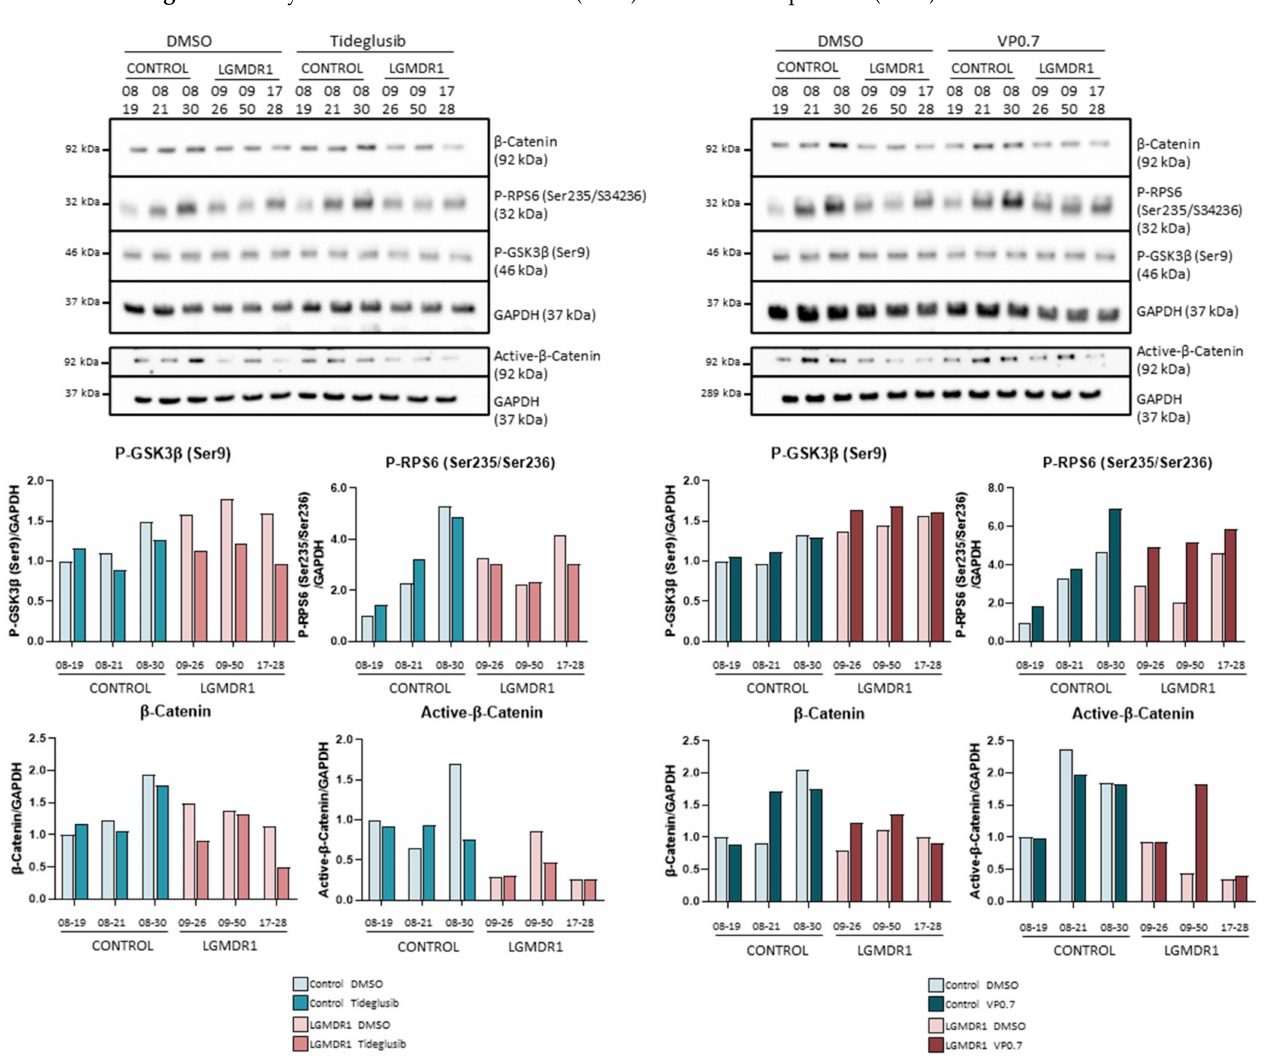
Figure 7. Analysis of fibroblasts of controls ( n = 3) and LGMDR1 patients ( n = 3) treated with the GSK-3 inhibitors, tideglusib and